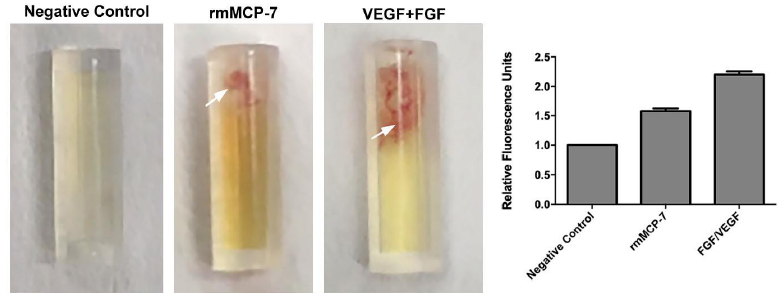
Figure 2. rmMCP-7 induces endothelial cell invasion into DIVAA ™ inserts. Representative photographs demonstrate blood vessel growth (arrows) into the open end of the angioreactors only in the presence of rmMCP-7 or VEGF and FGF. DIVAA ™ assay was performed in mice implanted with angioreactors containing Geltrex ® (negative control), or rmMCP-7 or VEGF and FGF (positive control). Graph shows the quantification of blood vessel growth, as measured by FITC-lectin fluorescence of the cell contents of each reactor.